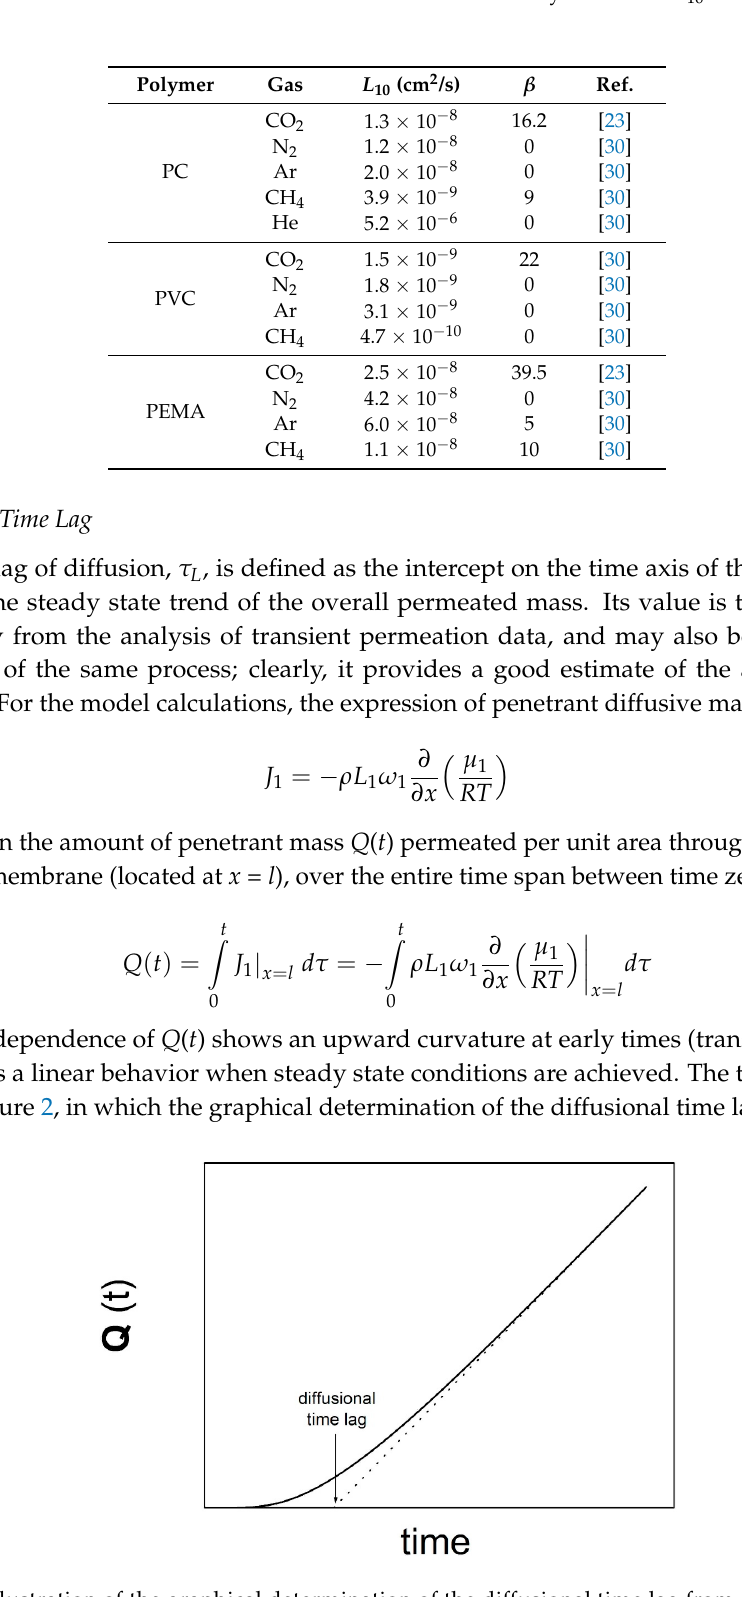
Figure 2. Illustration of the graphical determination of the diffusional time lag from the permeated mass per unit area vs. time plot.